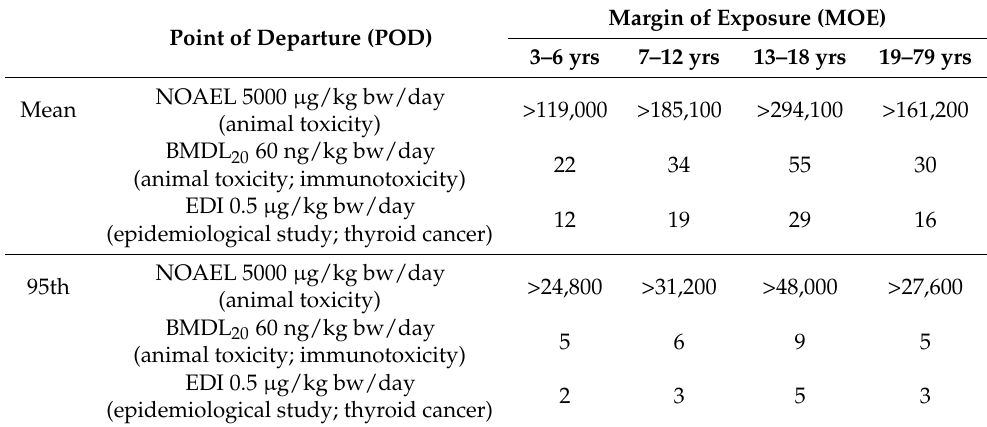
Table 4. Margin of exposure (MOE) of current exposure of bisphenol A by age in Korean gene- ral